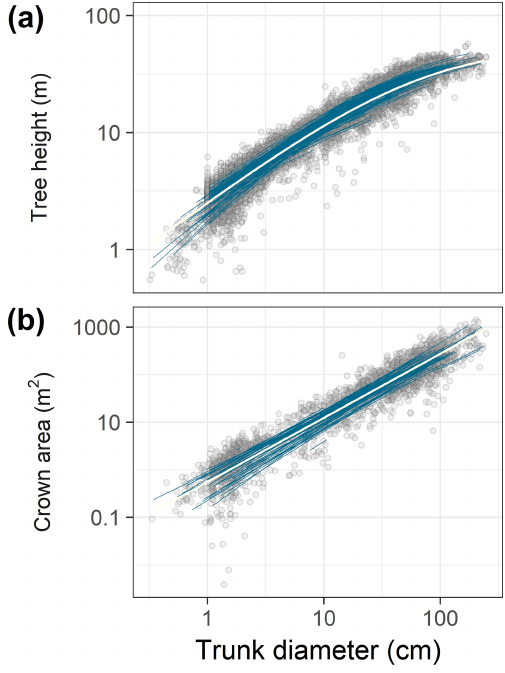
Figure 1. Data (points) and best-fit allometric relationships (lines) for tree height (a) and crown area (b) in relation to trunk diam- eter. In each panel, blue lines correspond to species-specific fits, and the white line to the community-averaged model, both from the best hierarchical model (Tables 1 and 2). The best model for tree height was based on a generalized Michaelis–Menten func- tion (a) , whereas the best model for crown area included a power function (b) . Note the log scales on all